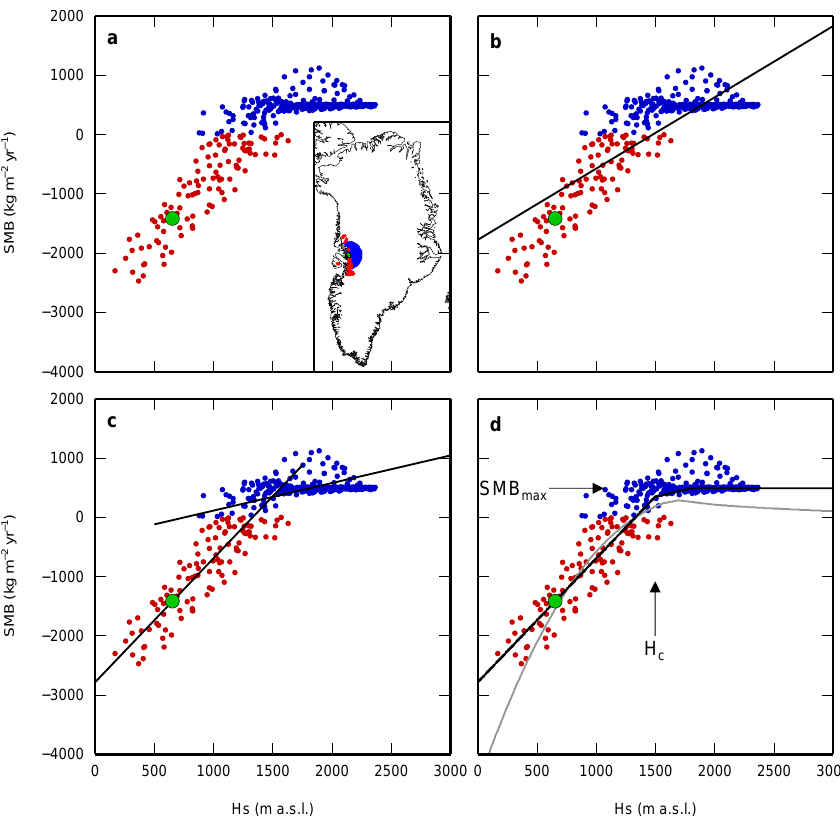
Fig. 2. Example of the SMB gradient method for a location in the ablation area. Blue (red) dots indicate positive (negative) SMB values and locations, green dot indicates reference H s -SMB value for this specific grid point and black lines denote relations between SMB and H s using different methods: (a) scatter plot of SMB as a function of H s ; (b) simple linear regression; (c) separate regressions for ablation and accumulation regimes; (d) final SMB gradient result maximized to a value (SMB max ) in the accumulation regime. H c is the elevation of intersection between the accumulation and ablation regime. Grey line represents SMB calculated by a PDD